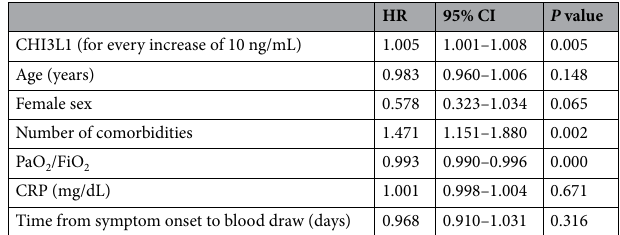
Table 2. Multivariable Cox regression analysis predicting transfer to ICU/death. HR Hazard ratio, 95% CI 95% confidence interval,